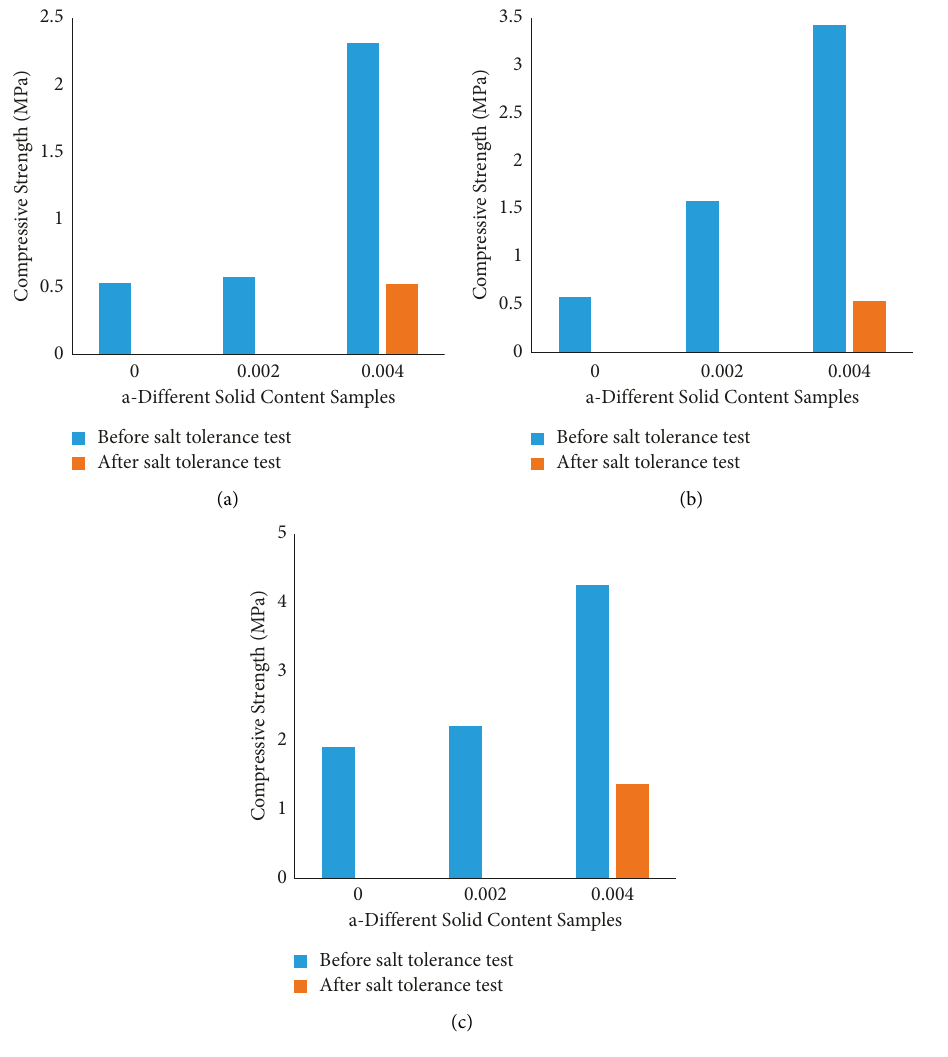
Figure 7: Salt resistance strength of cured